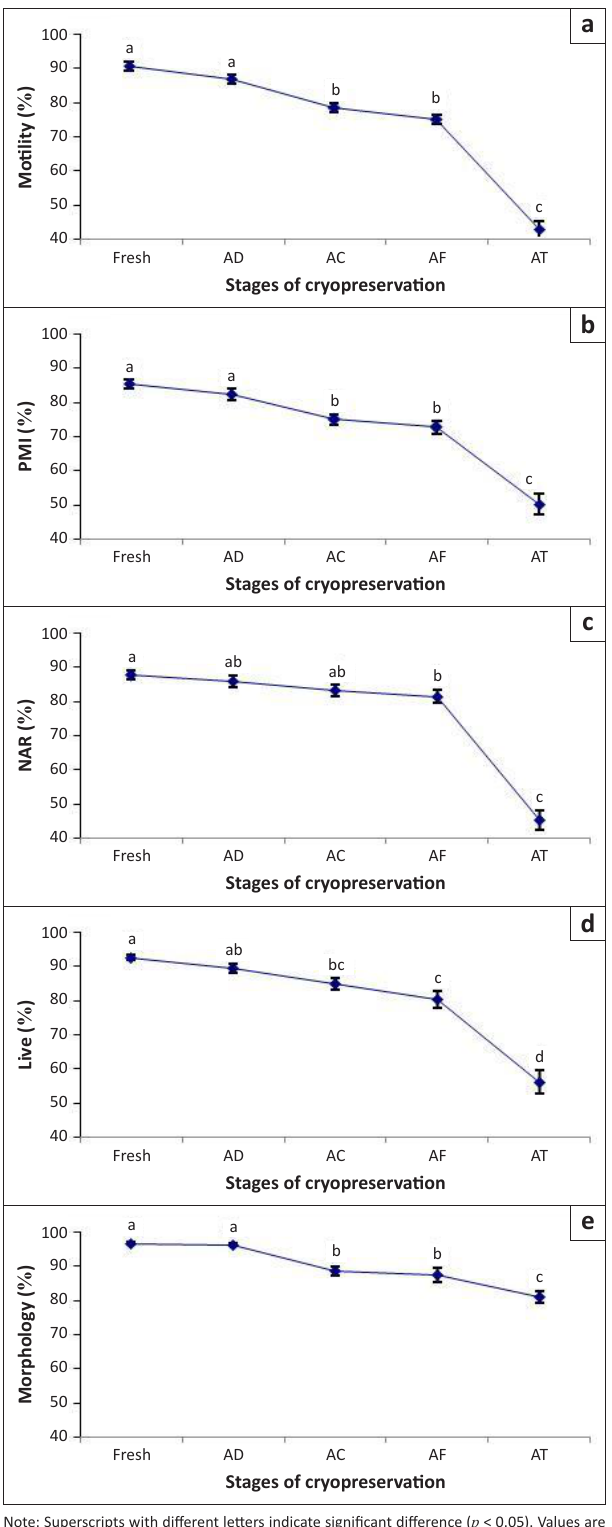
FIGURE 1: Effect of stages of cryopreservation on motility, after dilution, after cooling, after equilibration, and after freezing and thawing, on the percentile of (a) motility, (b) plasma membrane integrity, (c) normal acrosomeapical ridge, (d) live and (e) morphology of